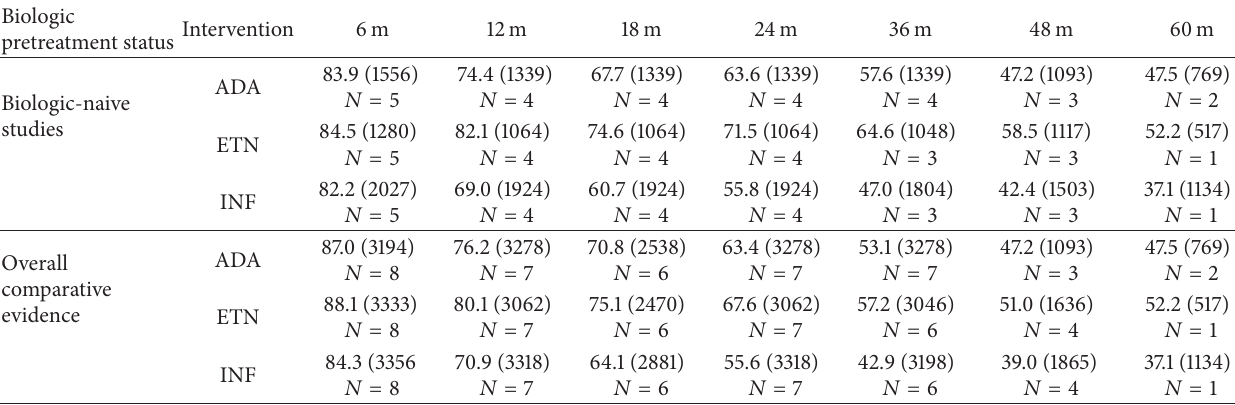
Table 2: Pooled drug survival rates with number of patients/studies evaluated for ETA, ADA, and INF at different time points among the included studies (12 comparative studies